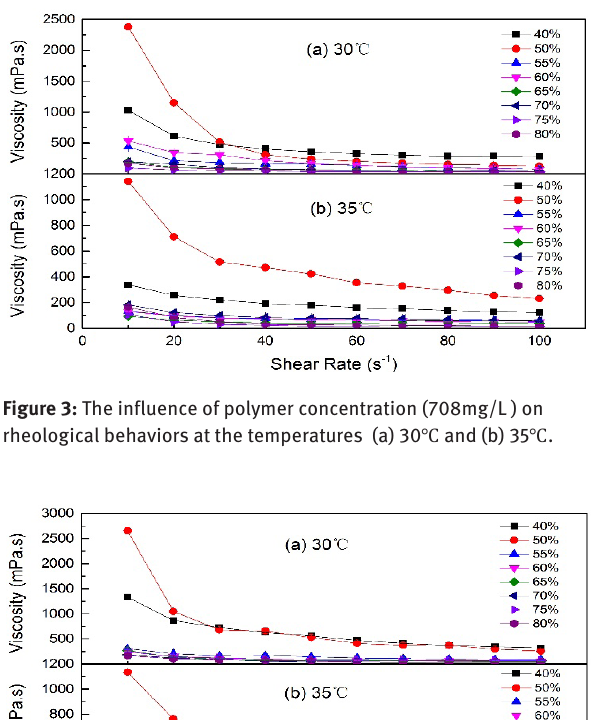
Figure 4: The influence of polymer concentration (920mg/L ) on rheological behaviors at the temperatures (a) 30 .